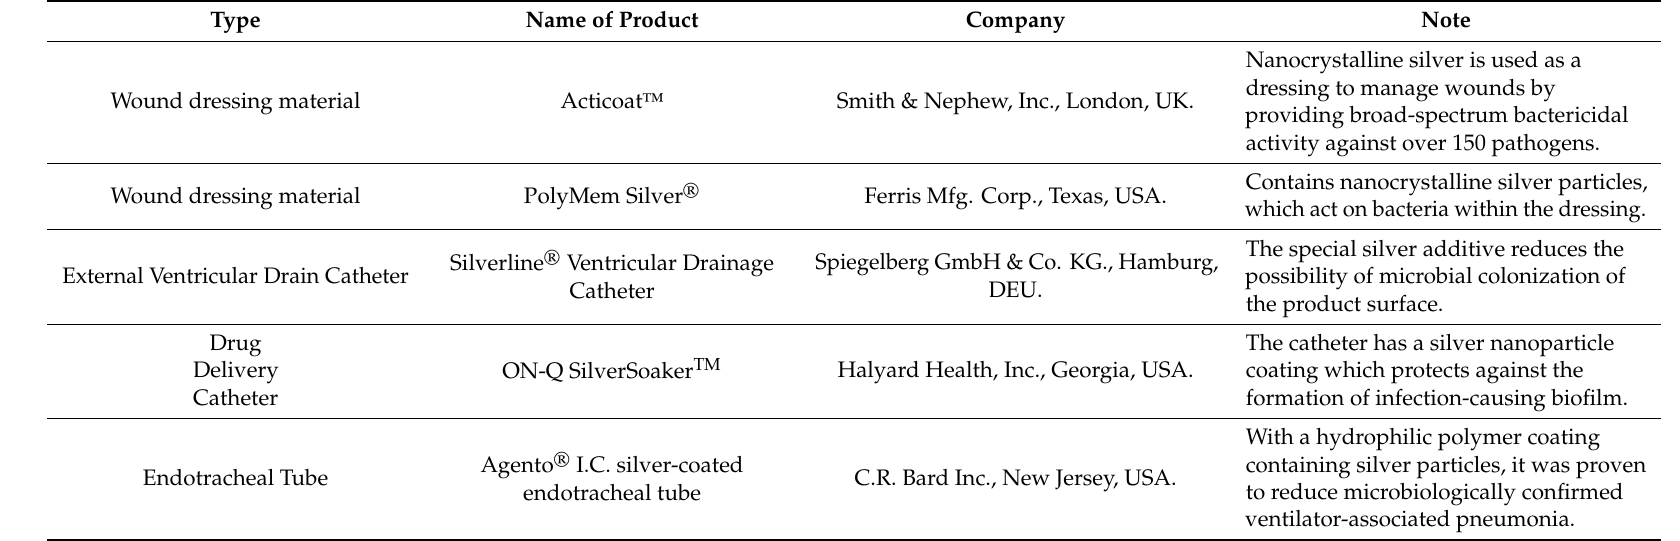
Table 3. Some of the commercially available Ag NP-based materials for clinical